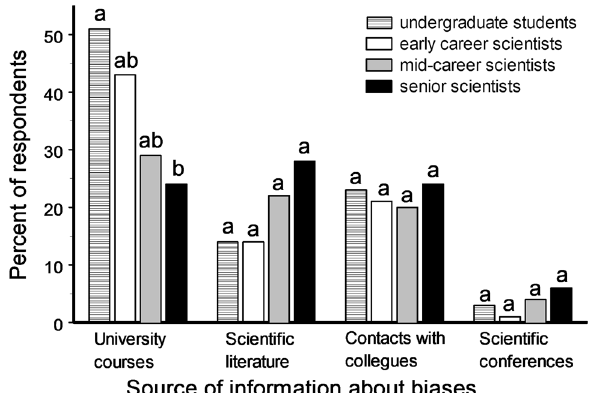
Figure 2. Sources of the first information about biases in relation to the stage of respondent’s research career, as reported by 35 undergraduate students, 122 early career scientists, 49 mid-career scientists and 95 senior scientists. Bars marked with different letters differ from each other at P < 0.05 within each group ( χ 2 test).